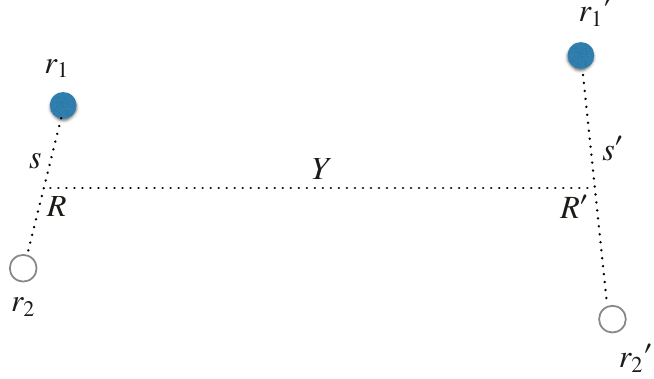
Figure 5 . The various coordinates that are used in the evaluation of the two particle density matrix elements h r 1 r 2 jD Q j r 0